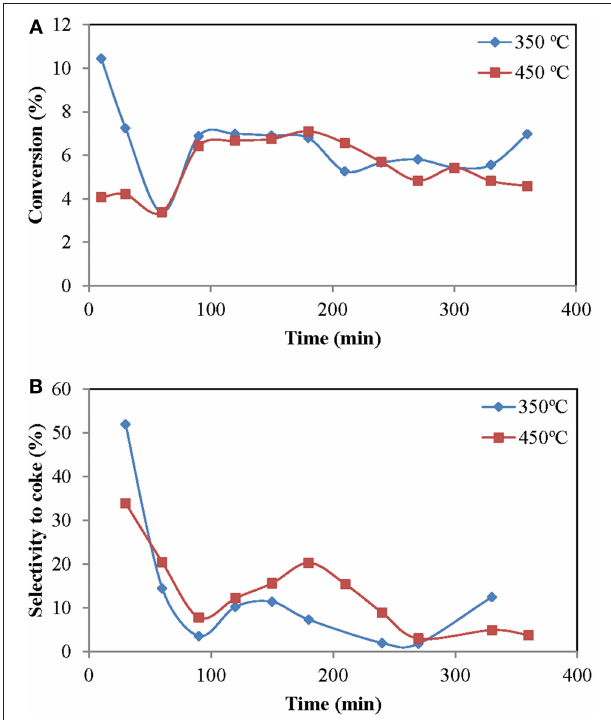
FIGURE 1 | Influence of the reduction temperature in methane aromatization reaction (time on stream): (A) Methane conversion, (B) Selectivity to coke. Operating conditions: W cat = 12g, CH 4 :O 2 :N 2 = 70:1.5: 28.5%; u rlowerzone = 2.5 and T = 700 ◦